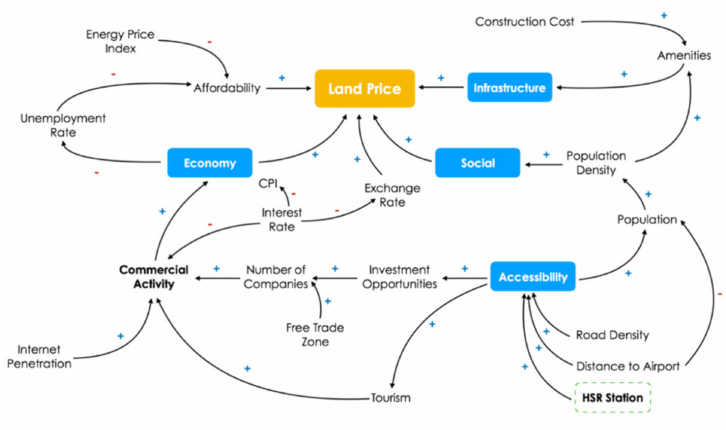
Figure 3. Causal loop diagram for land